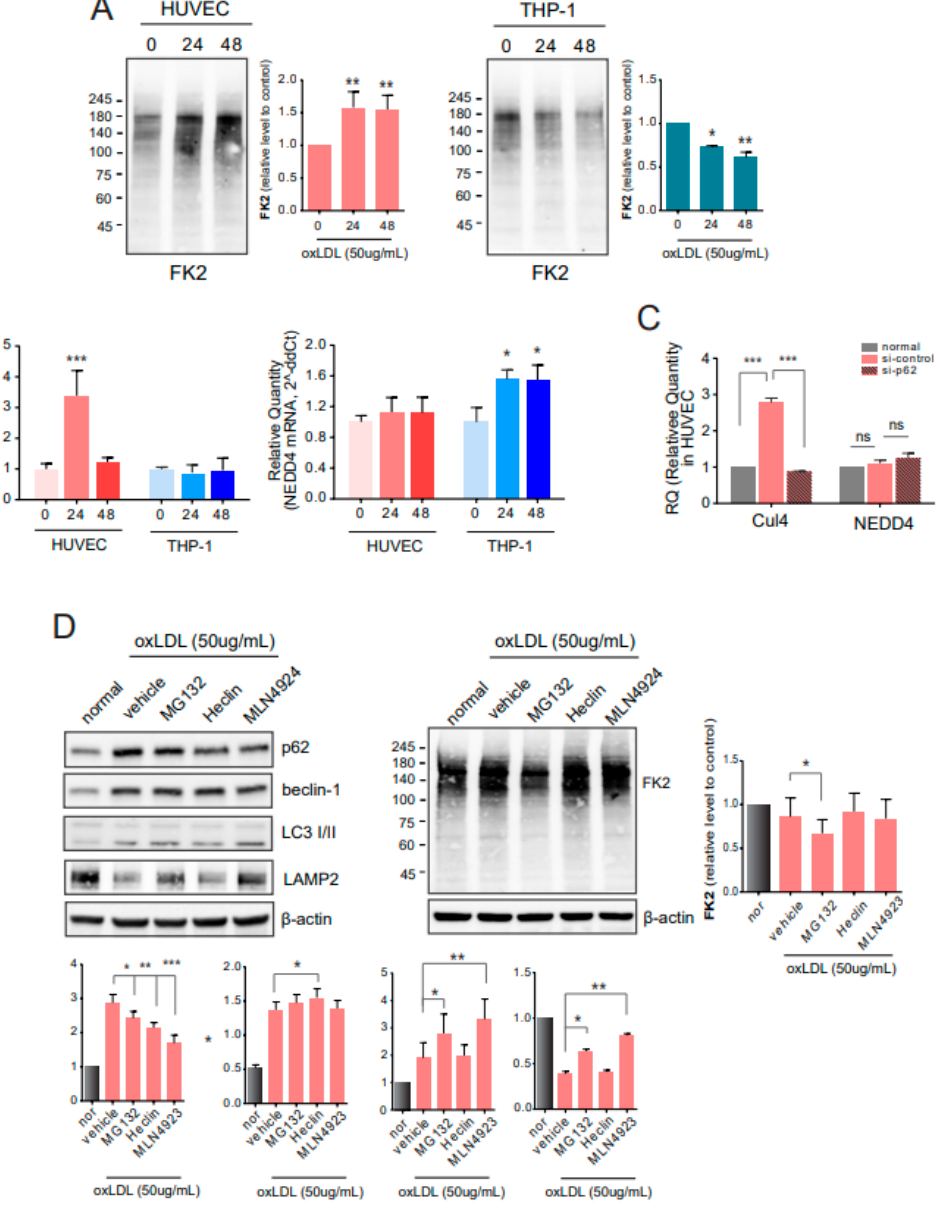
Figure 4. Involvement of E3 ligases in autophagy. ( A ) At several time points after oxLDL treatment, polyubiquitinated proteins in HUVECs and THP-1 cells were detected by western blotting with antibodies against FK2. ( B ) The qPCR for Cul4 and NEDD4 was performed in HUVECs and THP-1 cells. ( C ) After administering p62-siRNA to HUVECs, the mRNA levels were measured by qPCR. ( D ) Changes in autophagy-related molecules and polyubiquitinated proteins in HUVECs were assessed by western blotting (left) and quantified (right). ns, no significance; *, p < 0.05; **, p < 0.001, ***, p <